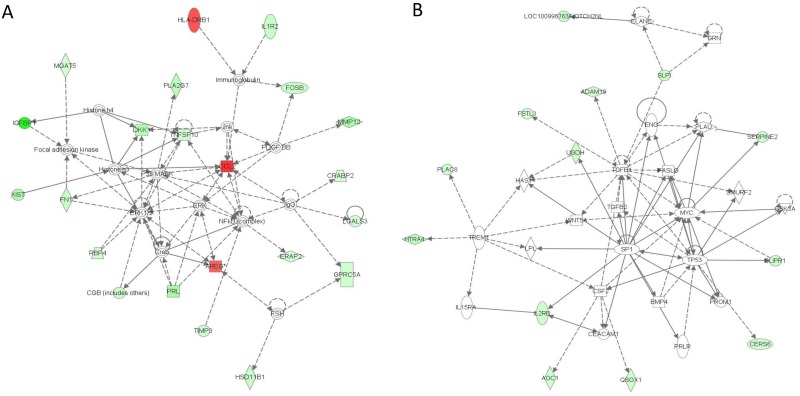
Shows the two highest scoring networks in IPA derived from the analysis of dysregulated genes in placentas of obese women vs. normal weight women.(A) Genes involved in embryonic development, organismal development and cancer. (B) Dysregulated genes involved in cellular movement, haematological system development and function, and immune cell trafficking. The intensity of the node colour indicates the degree of up- (red) or down- (green) regulation of gene expression. A white node represents a gene that is not part of our dataset, but is incorporated into the network through relationships with other genes. Nodes are displayed using various shapes that represent the functional class of the gene product, and a biological relationship between two nodes is represented as a line. Detailed information about the figure symbols can be found at www.ingenuity.com.